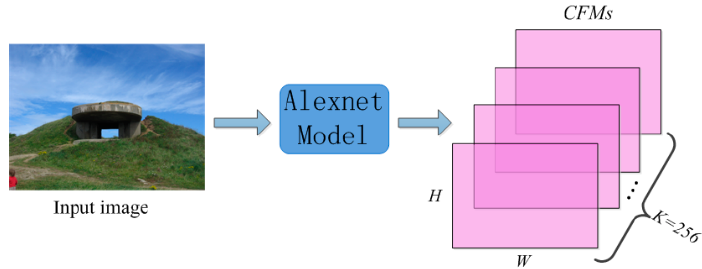
Figure 3. The illustration of convolutional feature maps (CFM) generation.